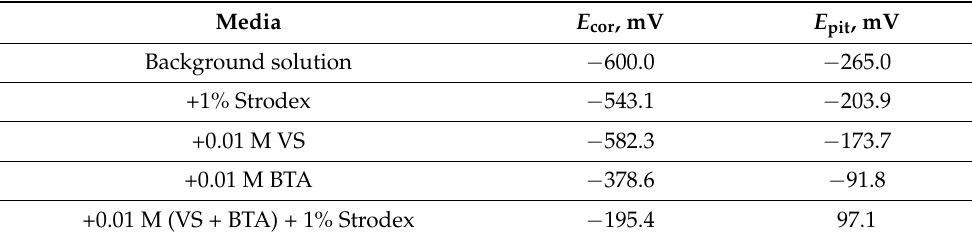
Table 2. Corrosion potential E cor and E pit of steel samples in the background electrolyte with different